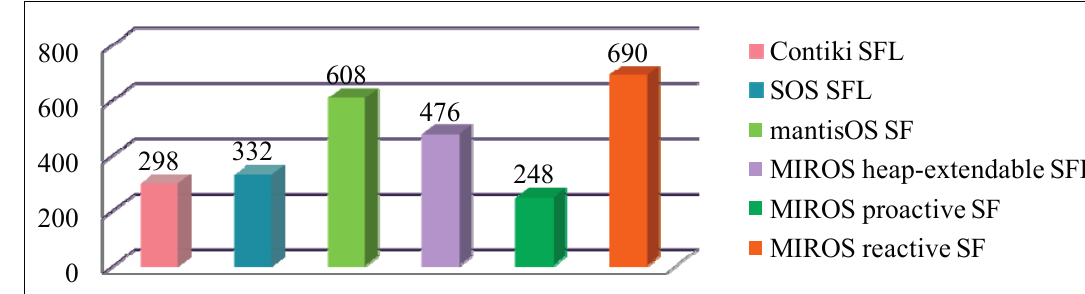
Figure 10. Code size of the different dynamic memory allocators.